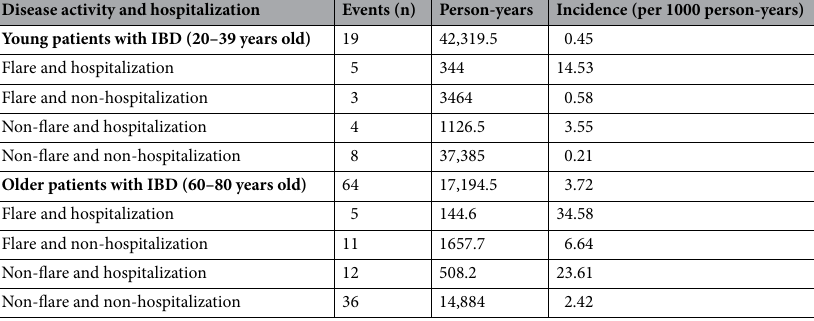
Disease activity and